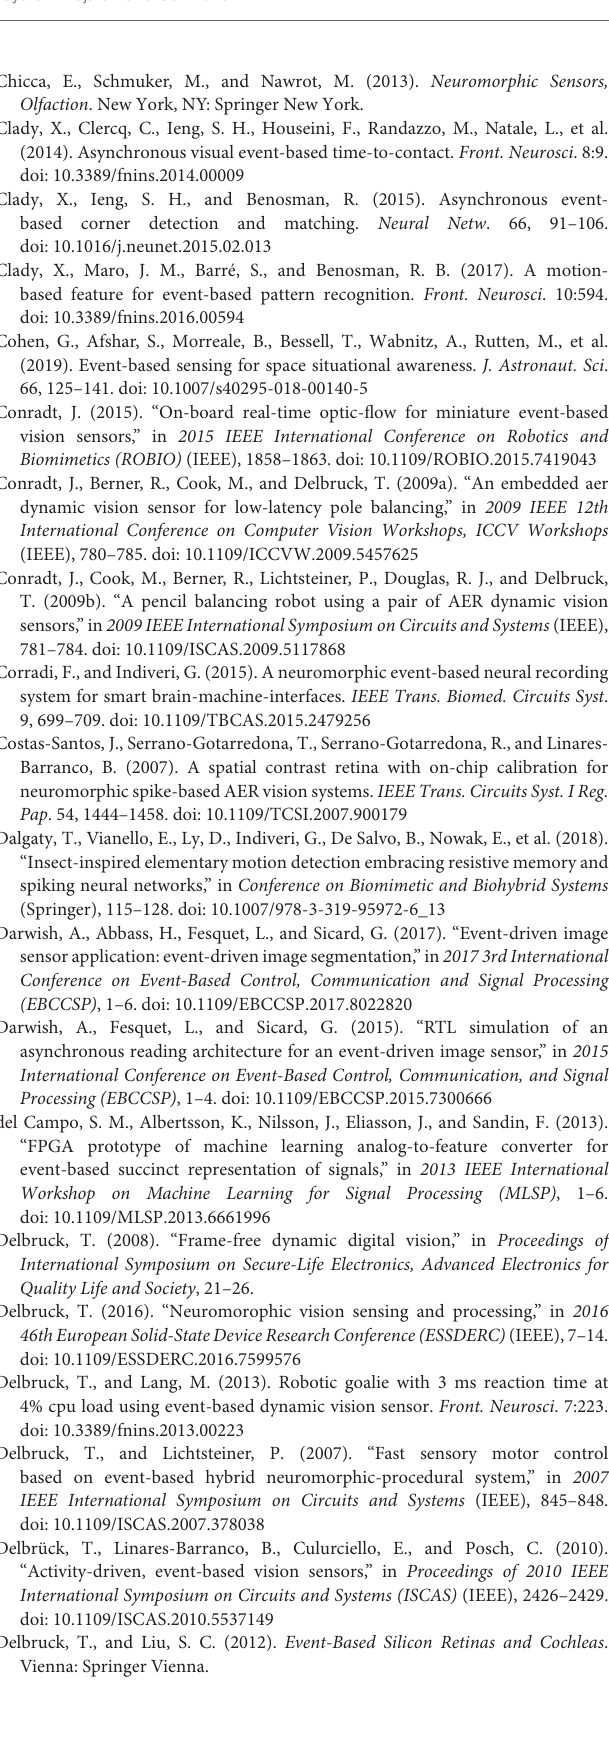
Frontiers in Neural Circuits |